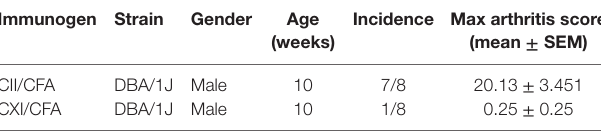
TaBle 1 | Disease incidence and Max arthritis score of C II IA and C XI IA mice.